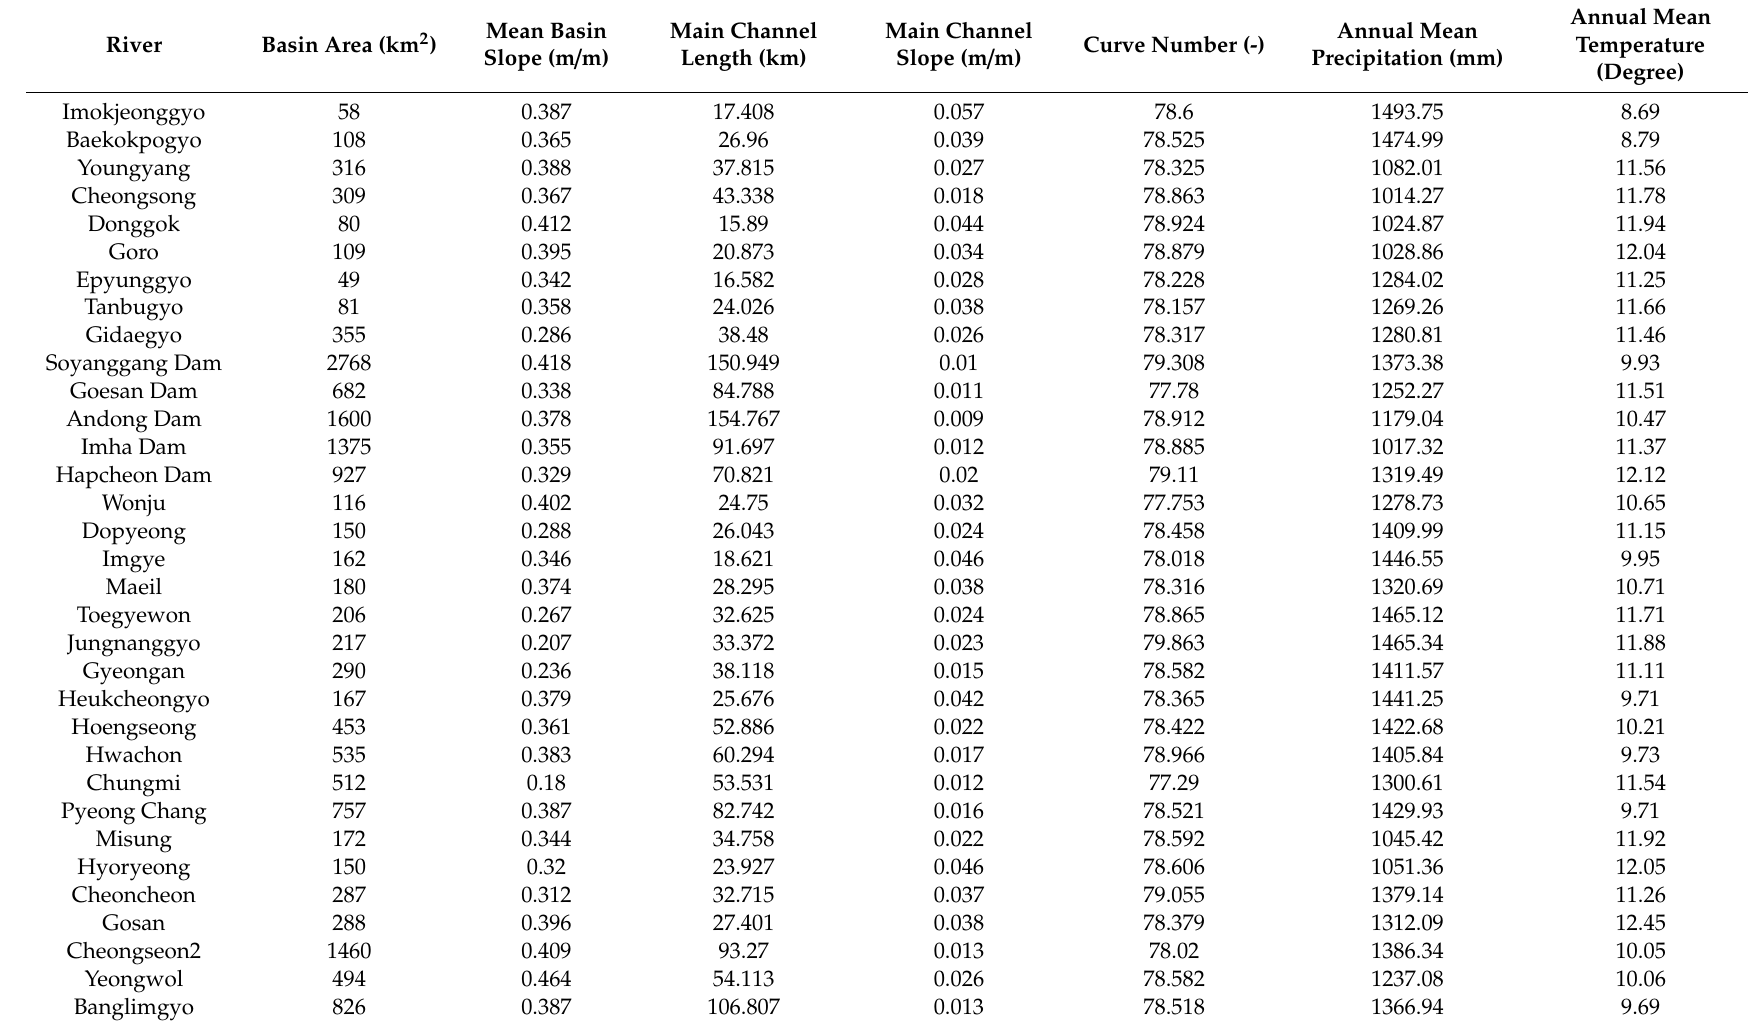
Table 1. Variables for the 33 river basins that were used in the